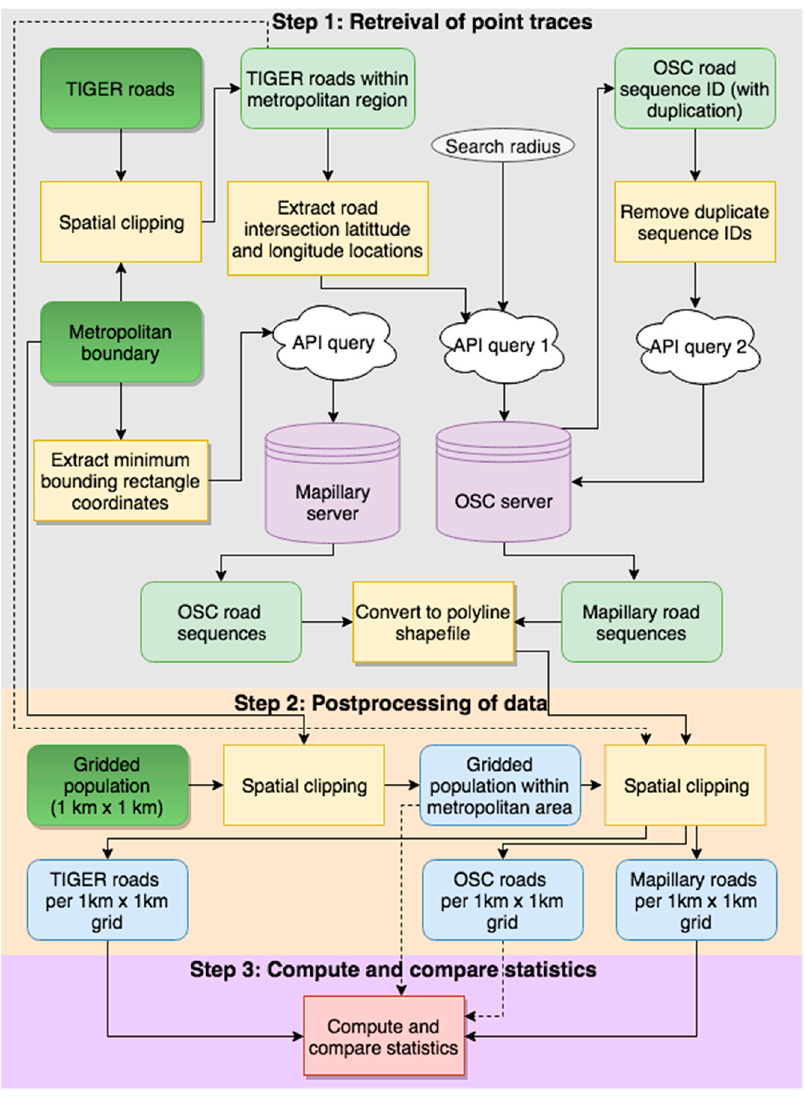
Figure 2. Overview of methodology.